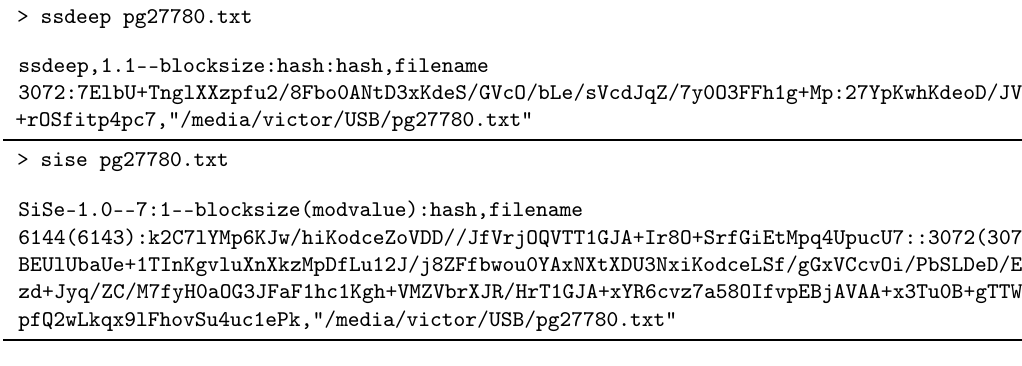
Table 3. ssdeep and SiSe signature